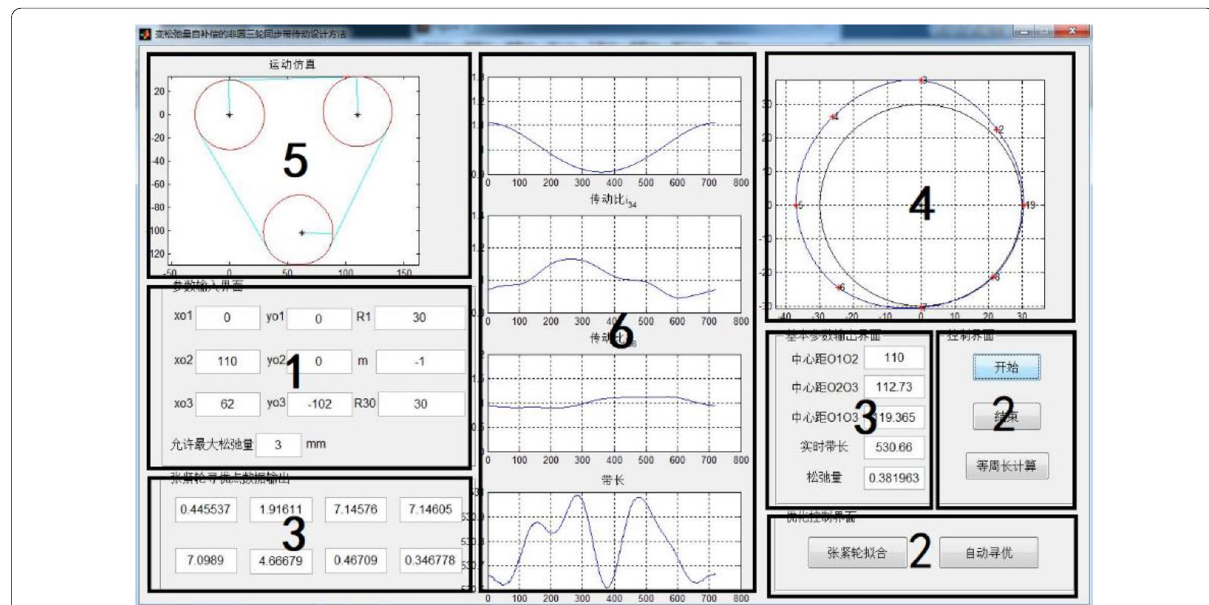
Figure 9 Noncircular three-pulley synchronous belt transmission optimization design software